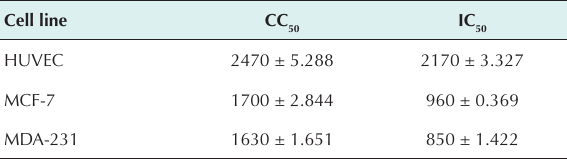
Table 1. The 50% Cytotoxic Concentration (CC50) and 50% Inhibition Concentration (IC50) of HSPPC Cell line